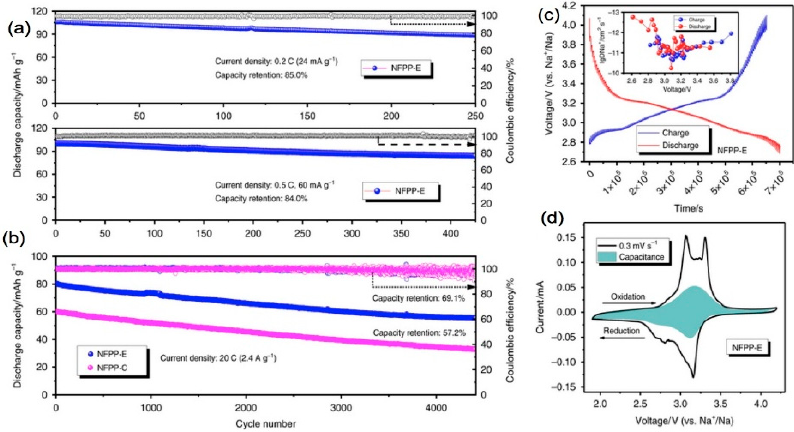
Figure 5. Performance of nanosized Na 4 Fe 3 (PO 4 ) 2 (P 2 O 7 ) plates (NFPP-E) and microporous Na 4 Fe 3 (PO 4 ) 2 (P 2 O 7 ) particles (NFPP-C) prepared by sol-gel. ( a ) Cycling stability of NFPP-E